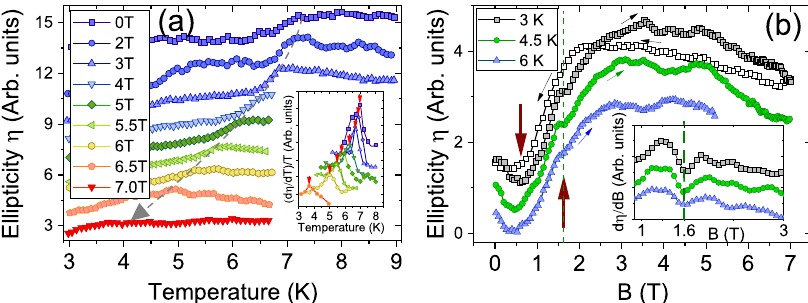
Fig. 4 Magnetic linear birefringence of α -RuCl 3 . a Iso-magnetic MLB as a function of the temperature. Data are plotted offset for clarity. The inset shows the calculated fi rst derivative of ellipticity (d η /d T ) normalized to the bath temperature. Red arrows indicate the maximum of the derivative indicating the magnetic phase transition, which is indicated by the gray dashed arrow in the main fi gure. b MLB η for B ab ∥ {1, 1, 0} as a function of the in-plane magnetic fi eld at different temperatures. The arrows indicate the anomalies discussed in the main text.